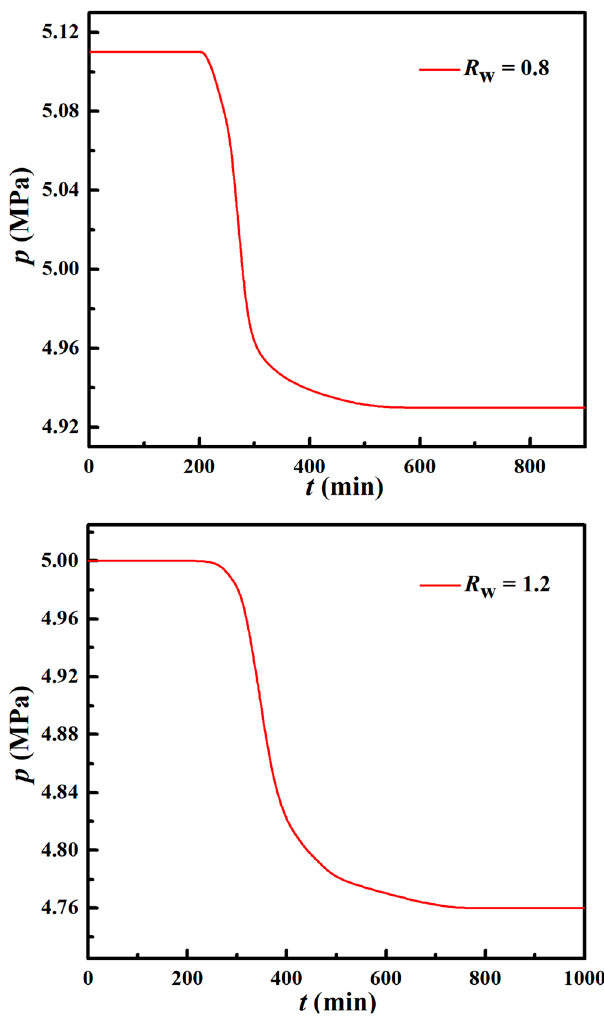
Figure 6. Dynamic curves of methane adsorption on the wet, hollow ZIF ‐ 8 nanoparticles with different amounts of pre ‐ adsorbed water.